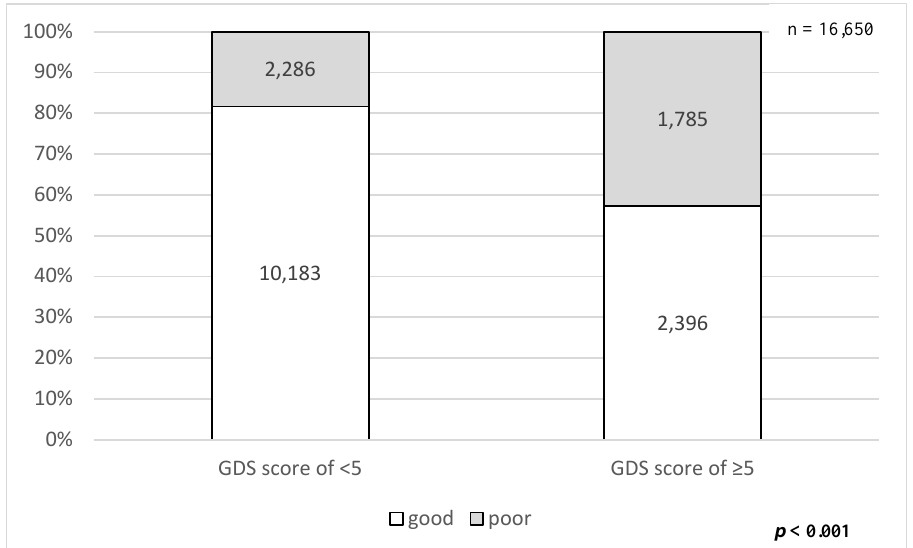
Figure 2. Prevalence of poor sleep between depressive and non-depressive participants. The rate of poor sleep in depressive participants (Geriatric Depression Scale [GDS] score of ≥5) was significantly higher than that in non-depressive participants (GDS score of <5) ( p <0.001). Table 2. Characteristics of participants divided by depressive status (GDS score of ≥5 or <5) and sleep quality (good or poor).